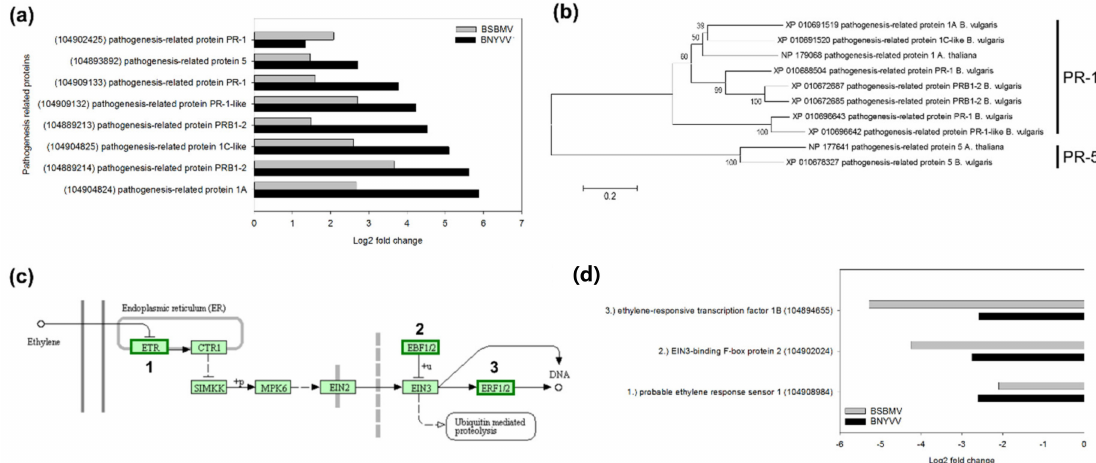
Figure 4. Analysis of DEGs associated with plant defence in sugar beet (susceptible genotype). ( a ) Log2 fold change of upregulated pathogenesis-related proteins (PR) in BNYVV- and BSBMV-infected plants. Brackets indicate the NCBI accession numbers. ( b ) Neighbour-joining phylogenetic tree of upregulated pathogenesis-related proteins during BNYVV and BSBMV infection. Amino acid sequences were retrieved from NCBI and PR-1 and PR-5 from Arabidopsis thaliana was included in the tree. ( c ) Ethylene signal transduction pathway of sugar beet retrieved from the KEGG database. Green highlighted components indicate that downregulated DEGs from both viruses were mapped. ( d ) Log2 fold change of DEGs mapped to the ethylene signal transduction